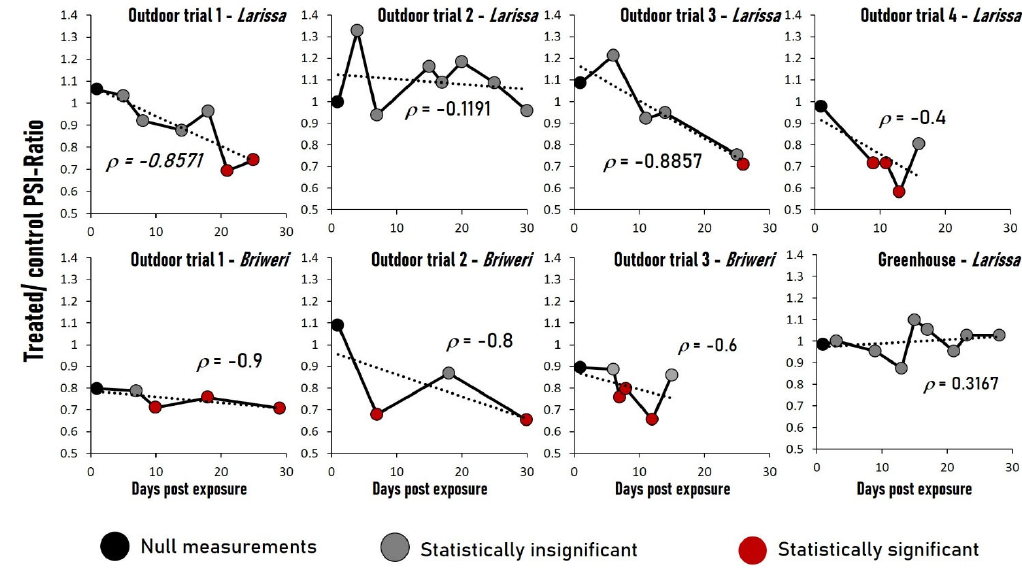
Figure 2. The courses of treated/control PSI ratios across the measurement time points in all trials. There are no statistically significant differences between treated and control groups in any null measurements. Black dots: null measurement. Gray dots: measurements with no statistically significant differences between treated and control groups. Red dots: measurements with statistically significant differences between treated and control groups. Also shown are the Spearman’s rho rank correlation coefficients ρ between the exposure time and the treated/control PSI ratios. ρ interpretation: − 0.2 < ρ < 0.2: no correlation; − 0.4 < ρ < − 0.2 and 0.2 < ρ < 0.4: weak correlation; − 0.6 < ρ < − 0.4 and 0.4 < ρ < 0.6: moderate correlation; − 1.0 < ρ < − 0.6 and 0.6 < ρ < 1.0: strong correlation.